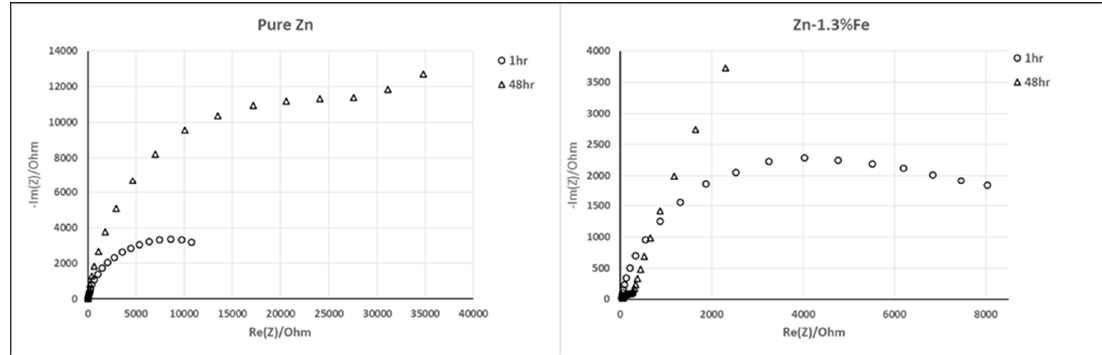
Figure 8. Nyquist plots obtained after immersion in PBS solution for up to 48 h.